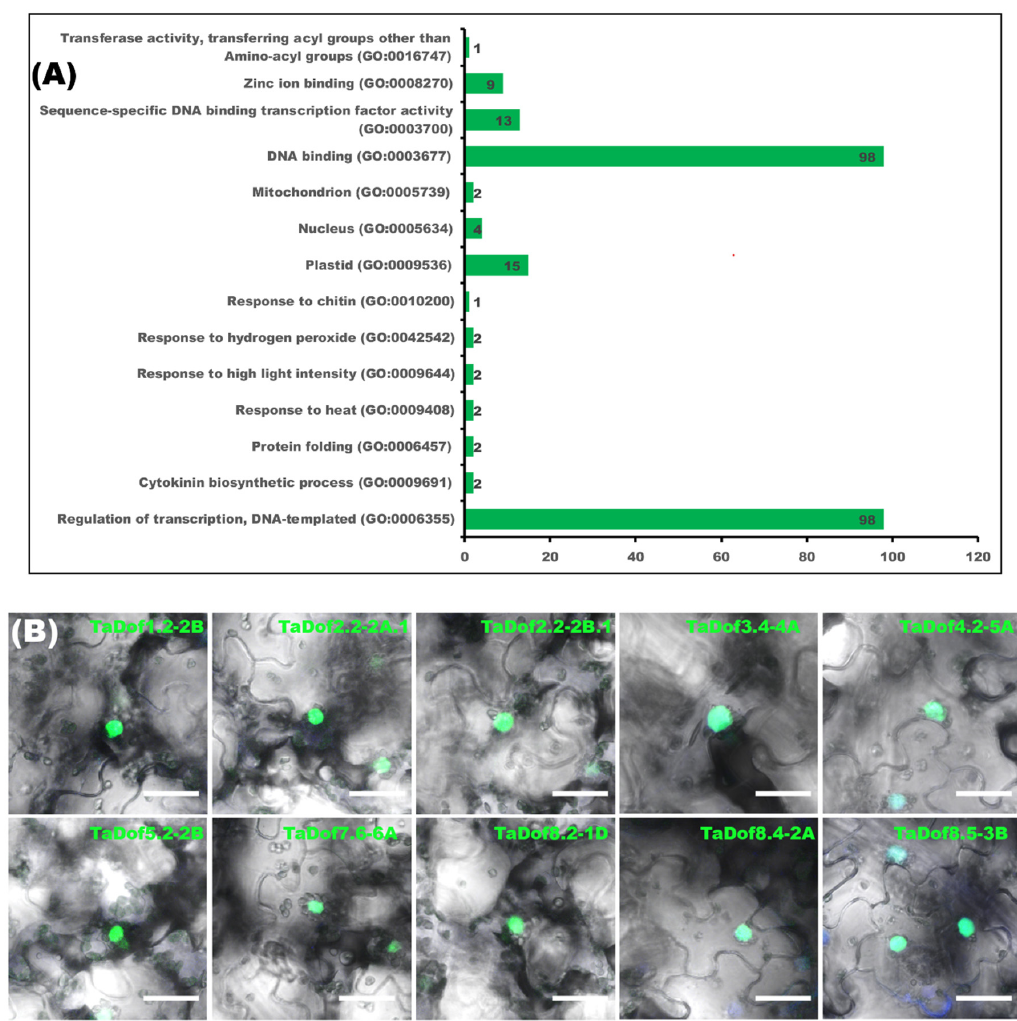
Figure 5. Functional annotation and sub-cellular localization analysis of TaDofs. ( A ) GO (Gene Ontology) annotation of TaDof genes. ( B ) Sub-cellular localization of TaDofs were experimentally confirmed by microscopy. Images were merged by bright field, green fluorescence, and DAPI channels (Bar = 25